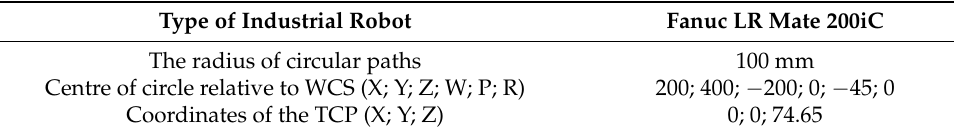
Table 3. Simulation conditions for positional